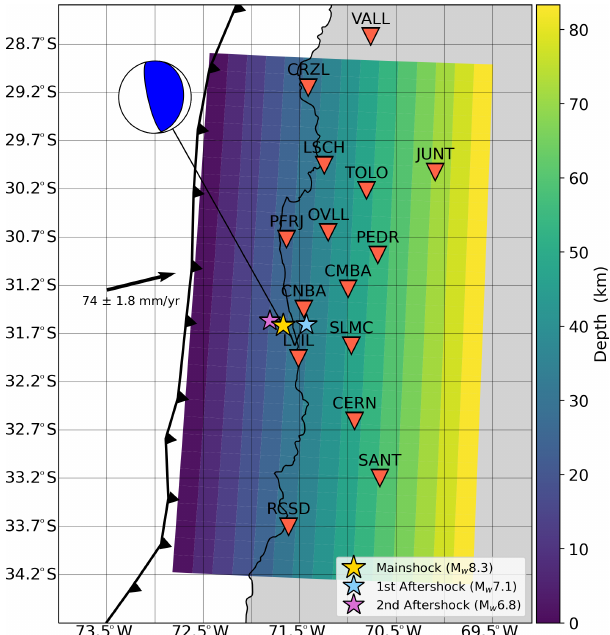
Figure 1. Setup used for the post-seismic slip inversions presented in this study. The fault plane (3 ◦ N of strike and 17 ◦ dipping angle) is color-coded according to depth. The red triangles are the GNSS stations. The yellow star shows the epicenter of the 2015, M w 8.3, Illapel, Chile earthquake and it is connected to its focal mechanism retrieved from the United States Geological Survey. The light blue and purple stars show the largest aftershocks reported by the Global Centroid Moment Tensor (GCMT) catalog ( M w 7.1 and 6.8, respec- tively). The chevron line shows the location of the plate boundary from Bird (2003). Finally, the black arrow shows the plate motion of the Nazca plate with respect to a fixed South America plate (DeMets et al.,